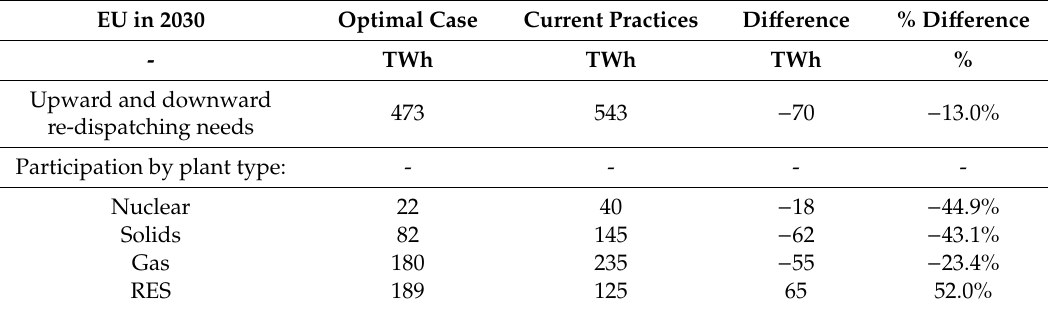
Table 8. Participation by plant type in the intra-day